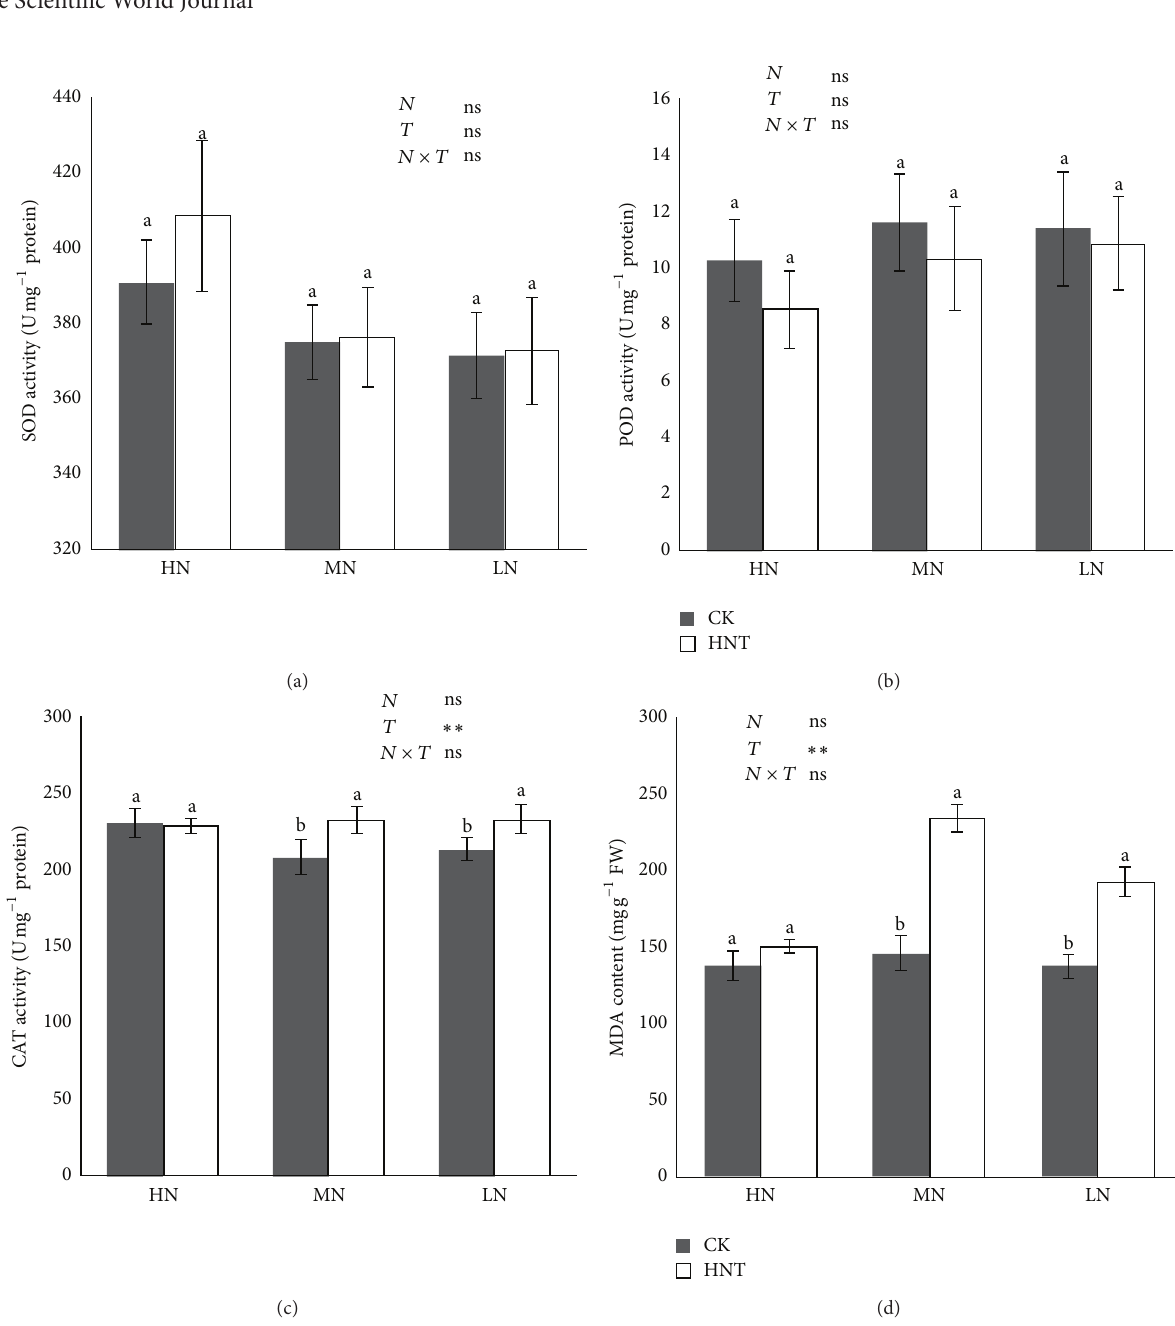
Figure 5: SOD, POD, and CAT activities and MDA ((a)–(d)) content of rice seedling leaf. Plants were grown under two different temperatures of 22 ∘ C (CK) and 27 ∘ C (HNT) and three different nitrogen levels of 10mg N/mL (LN), 40 mgN/mL (MN), and 160mgN/mL (HN). Statistical analysiswascarriedoutbetweentemperaturetreatmentsusinganANOVAwithTukey’stest.Columnswiththesameletterarenotsignificantly different ( 𝑃 < 0.05